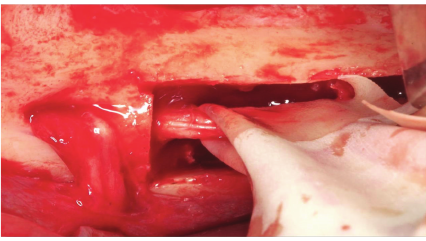
Figure 14: Traction beam with